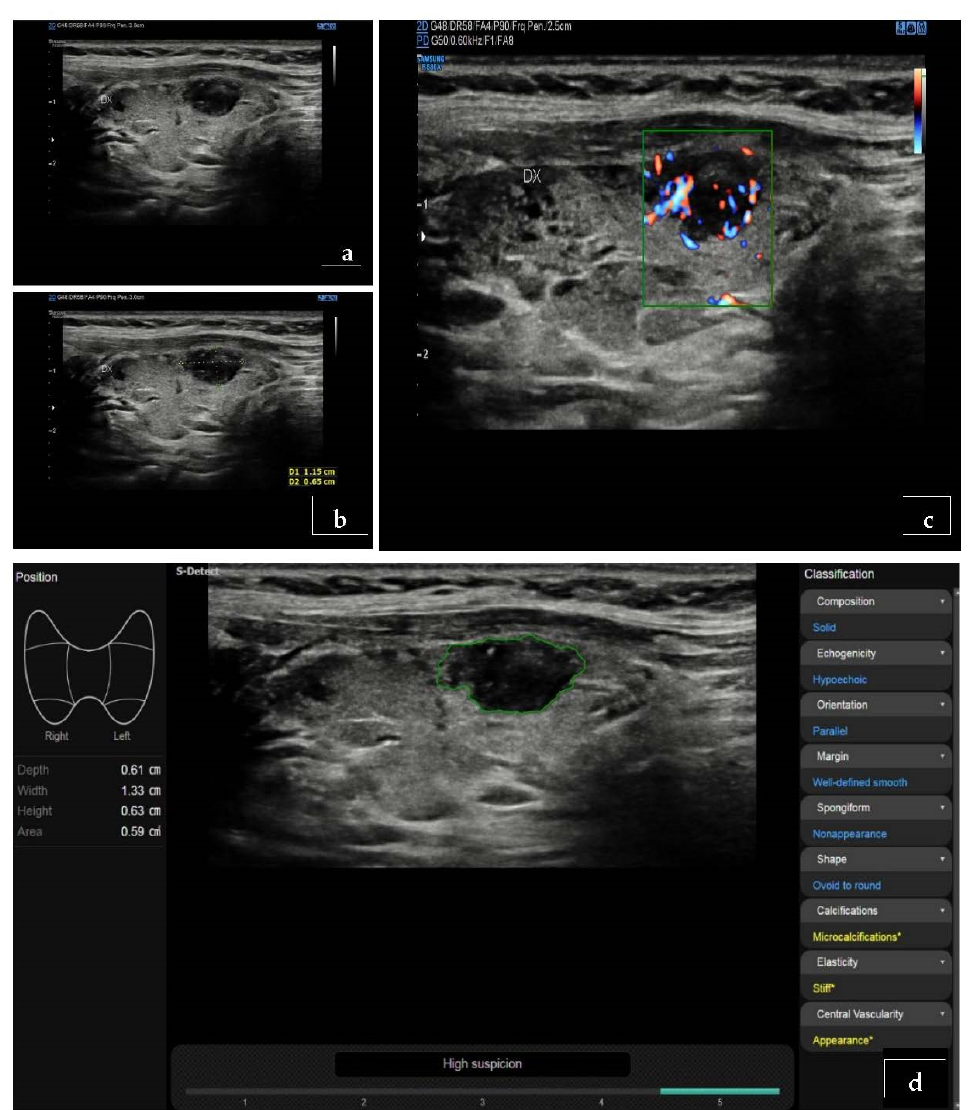
Figure 2. Histologically proved papillary carcinoma. ( a , b ) At B-mode, the nodule appears markedly hypoechoic. ( c ) At ColorDoppler-US evaluation, it shows type III vascular pattern (intra- and perinodular). ( d ) The evaluation with S-detect software (Samsung Medison, Co., Ltd., Seoul, Korea) confirms the high degree of suspicion (K-TIRADS